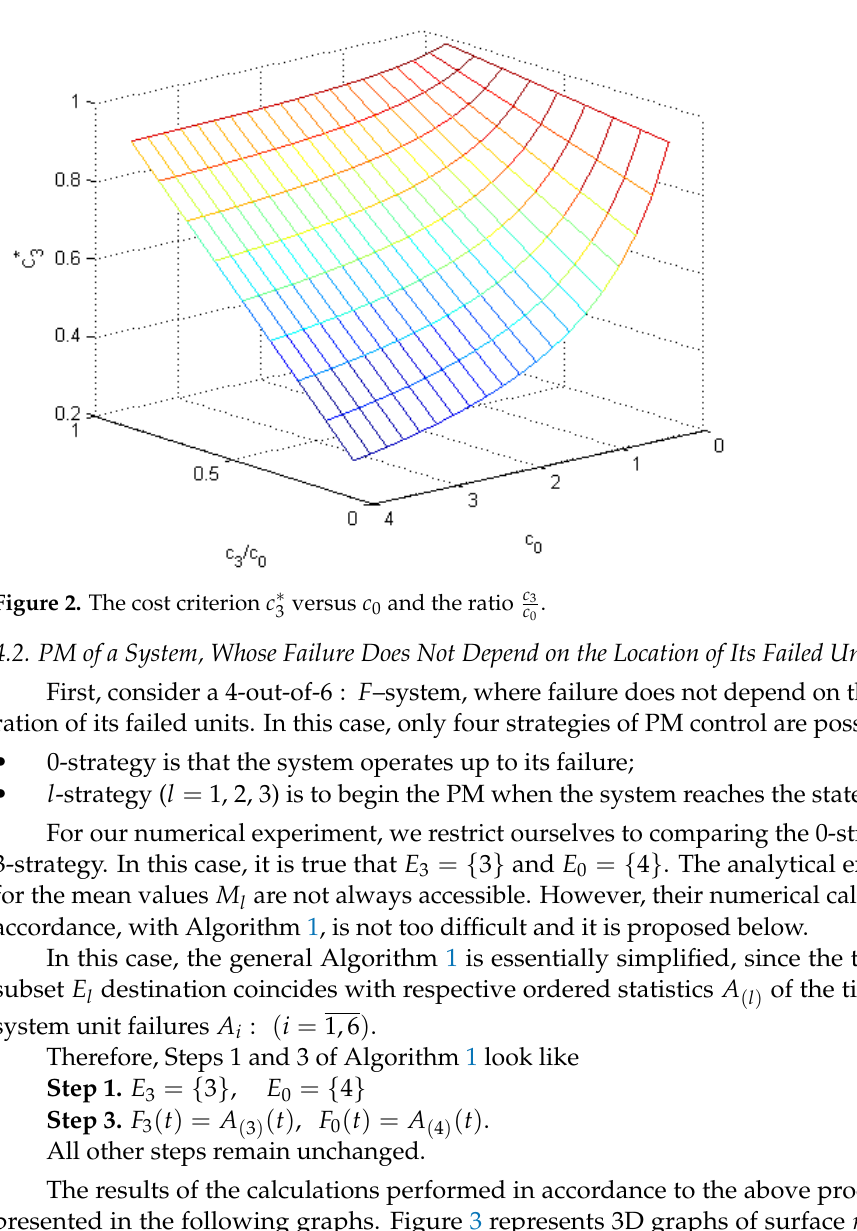
Figure 2. The cost criterion c ∗